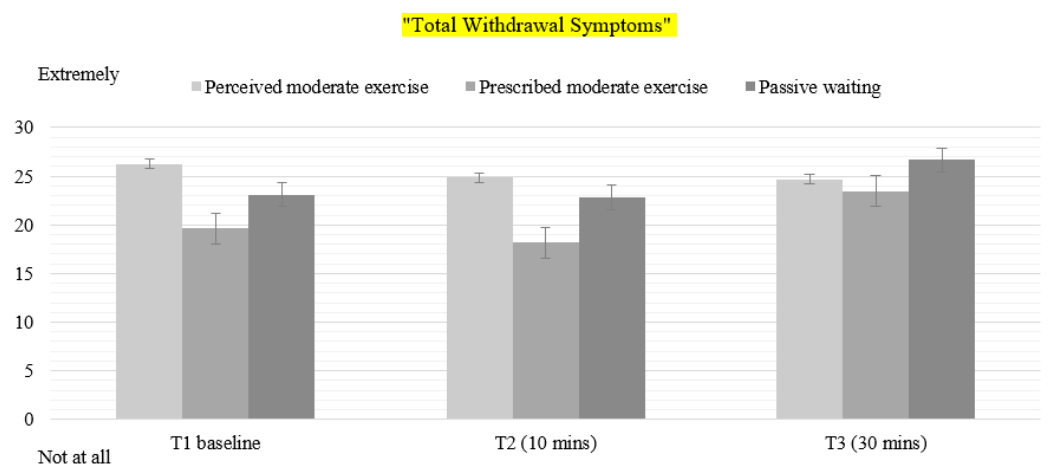
Figure 2. Mean values for Total Withdrawal Symptoms in all conditions. T1: Time 1—Baseline pre-